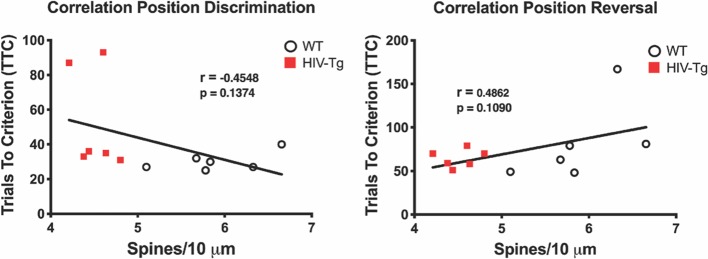
There was no relationship between overall dendritic spine density and the first two phases of the behavioral task.As expected, there was no observed correlation between dendritic spine density and either position discrimination or position reversal.